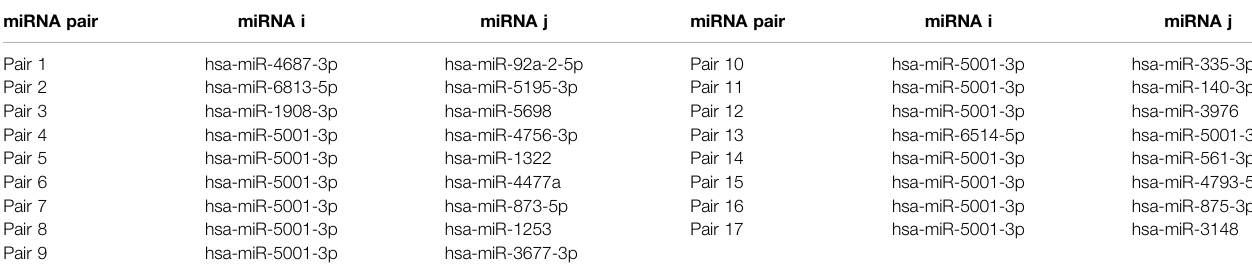
TABLE 3 | The information of the 17 miRNA pairs.